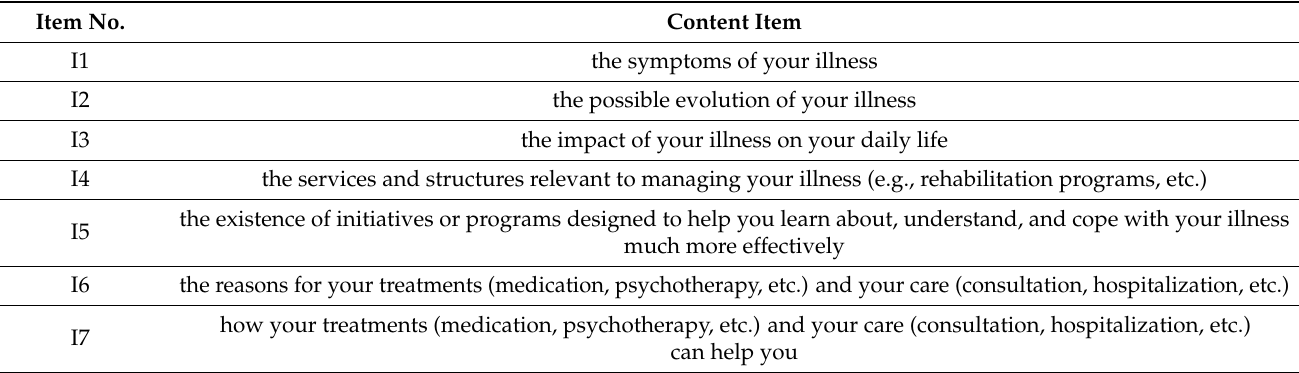
Table 1. List of items. You have been sufficiently informed